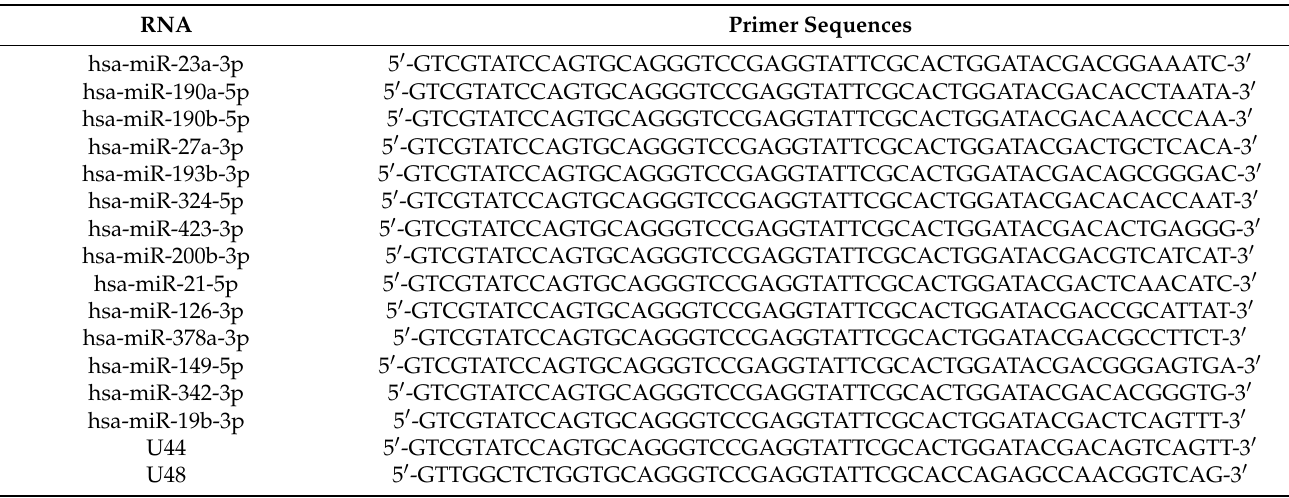
Table 1. Sequences of primers for miRNA reverse transcription. RNA Primer